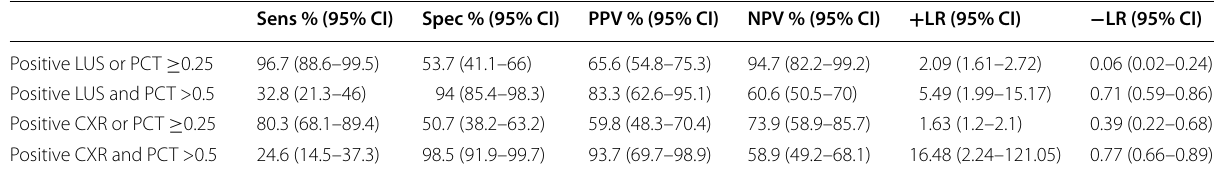
Table 4 Diagnostic performance of lung ultrasonography and chest radiograph combined with procalcitonin for the diagnosis of pneumonia